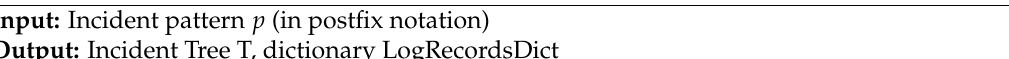
Algorithm 3 Incident tree generation